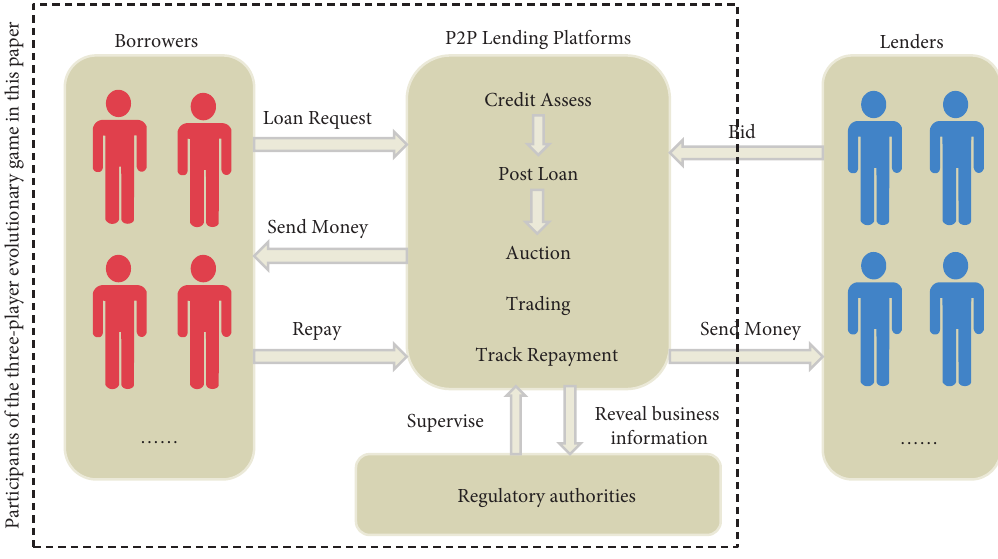
Figure 1: The working mechanism of P2P